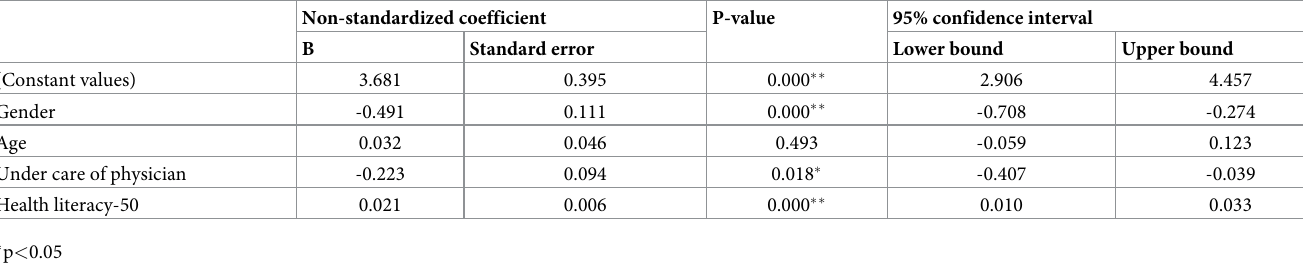
Table 8. Multivariate linear regression analysis of willingness to undergo vaccination, predictive